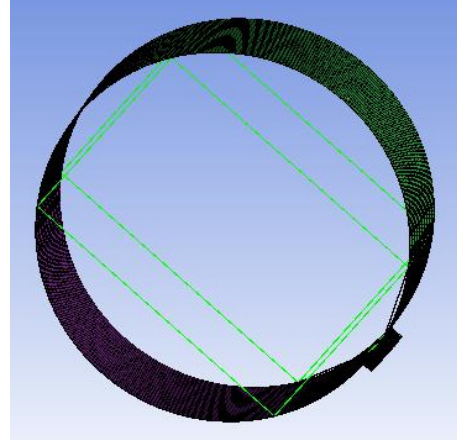
Figure 3. Meshing of the oil film. Table 1. Oil film size